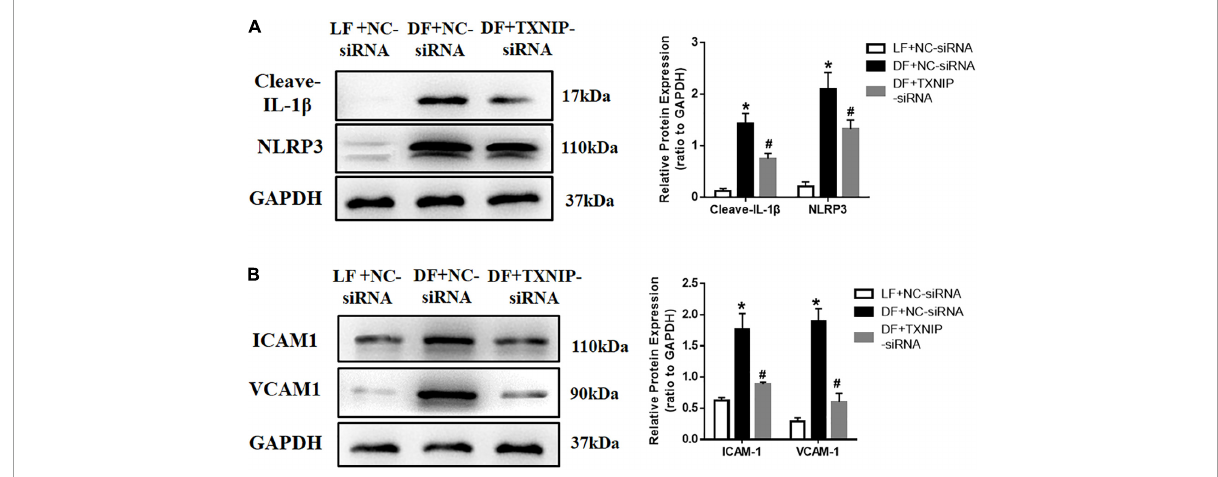
FIGURE6 TXNIP activation promoted the disturbed flow-induced pro-inflammatory response. (A) Representative Western Blots, along with quantification of cleaved-IL-1 β and NLRP3, (B) Representative Western Blots, along with VCAM1 and ICAM1 quantification, in the LF + NC-siRNA, DF + NC-siRNA, and DF + TXNIP-siRNA groups. The blot shows representative images of five independent experiments. Results are shown as mean ± SD. * P < 0.05 vs. LF + NC-siRNA, # P < 0.05 vs. DF +